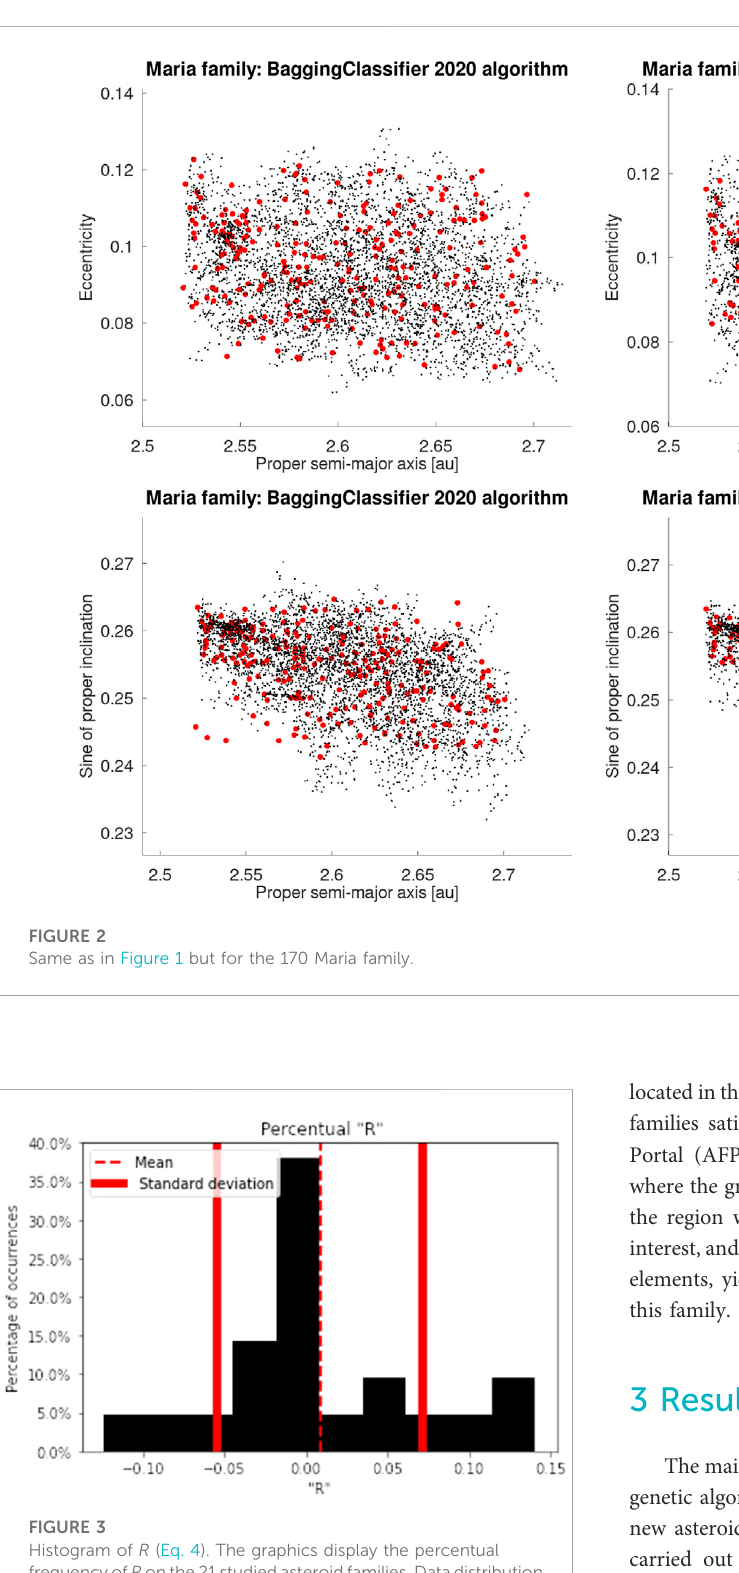
FIGURE 3 Histogram of R (Eq. 4). The graphics display the percentual frequencyof R onthe21studiedasteroidfamilies.Datadistribution moments: mean = 0.0086, standard deviation = 0.063, skewness = 0.268, and kurtosis =